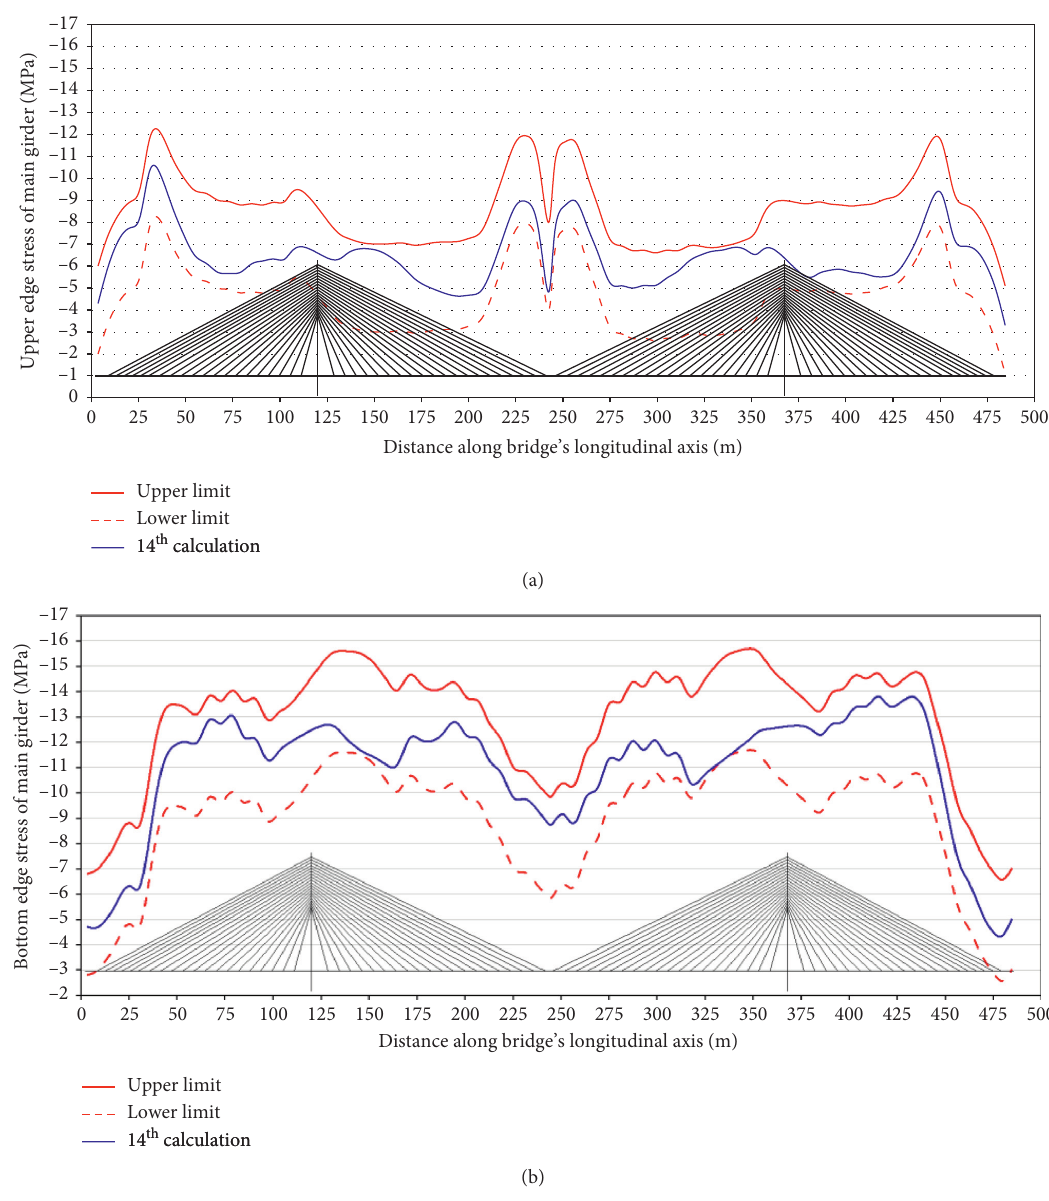
Figure 8: Stress state of the main girder at the completion of bridge. (a) Upper edge stress of the main girder. (b) Bottom edge stress of the main